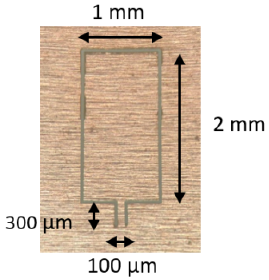
Figure 10. Microscope image of the hinged cantilever [87].